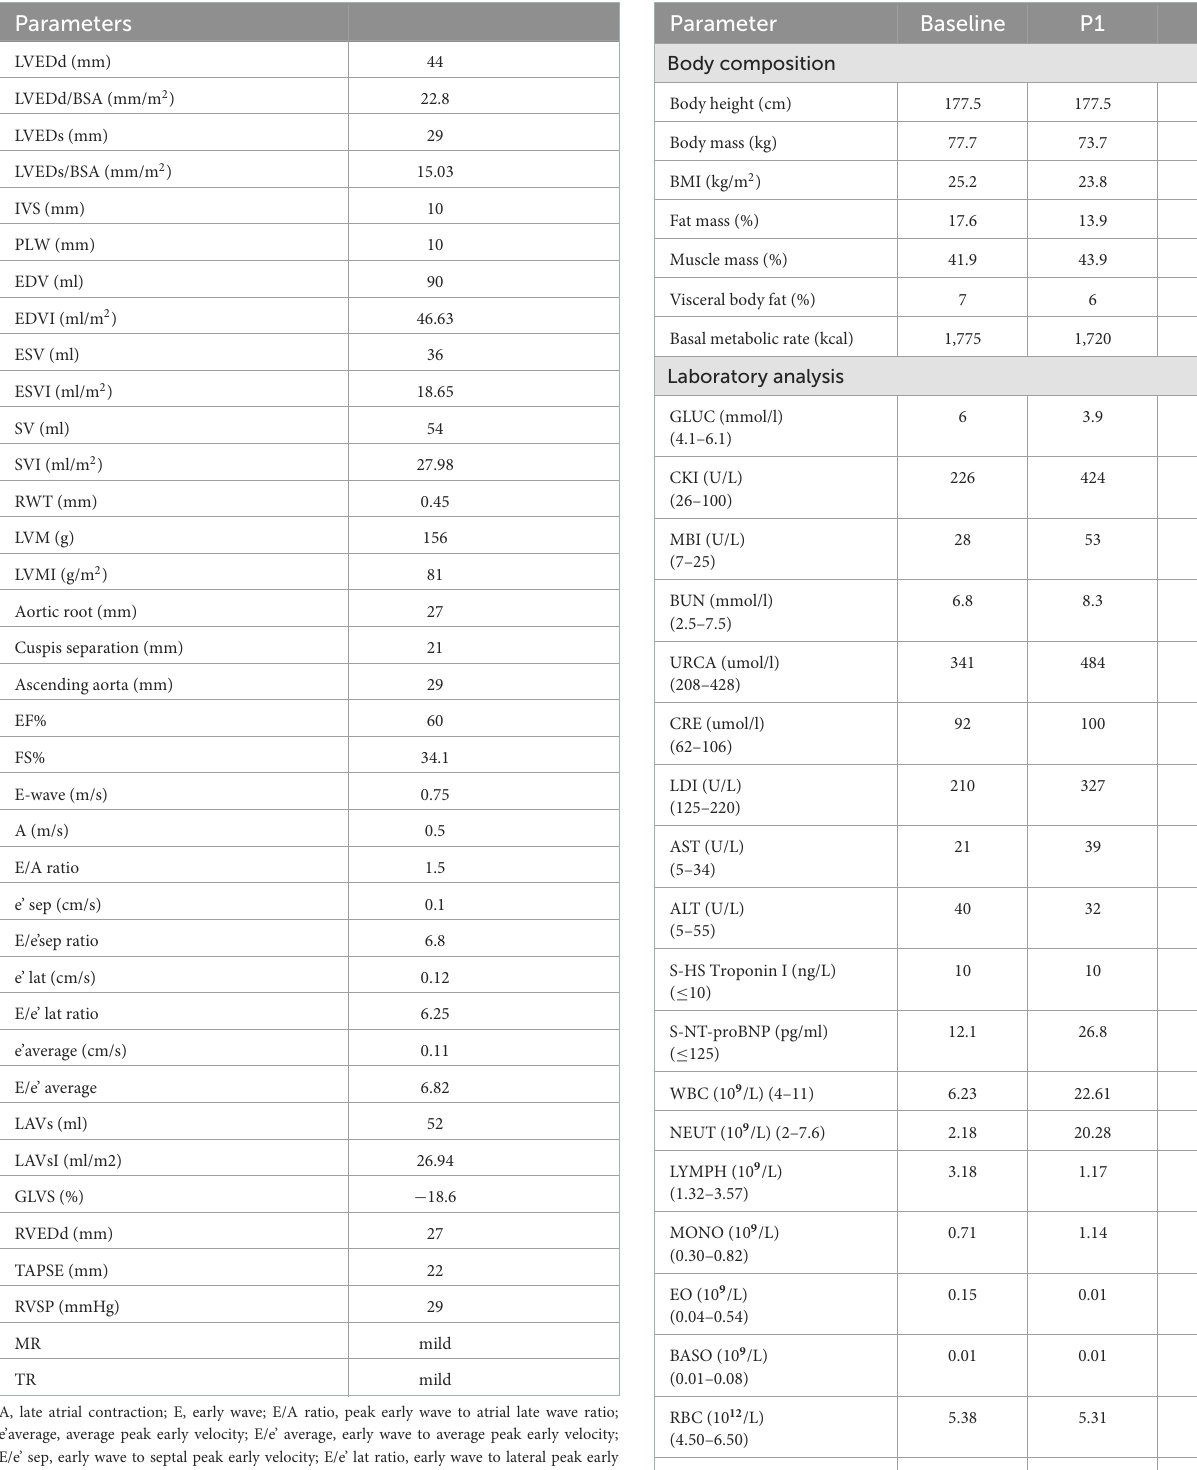
TABLE 1 Baseline echocardiographic parameters. TABLE 2 Comparison of analyzed baseline P1 and P 2